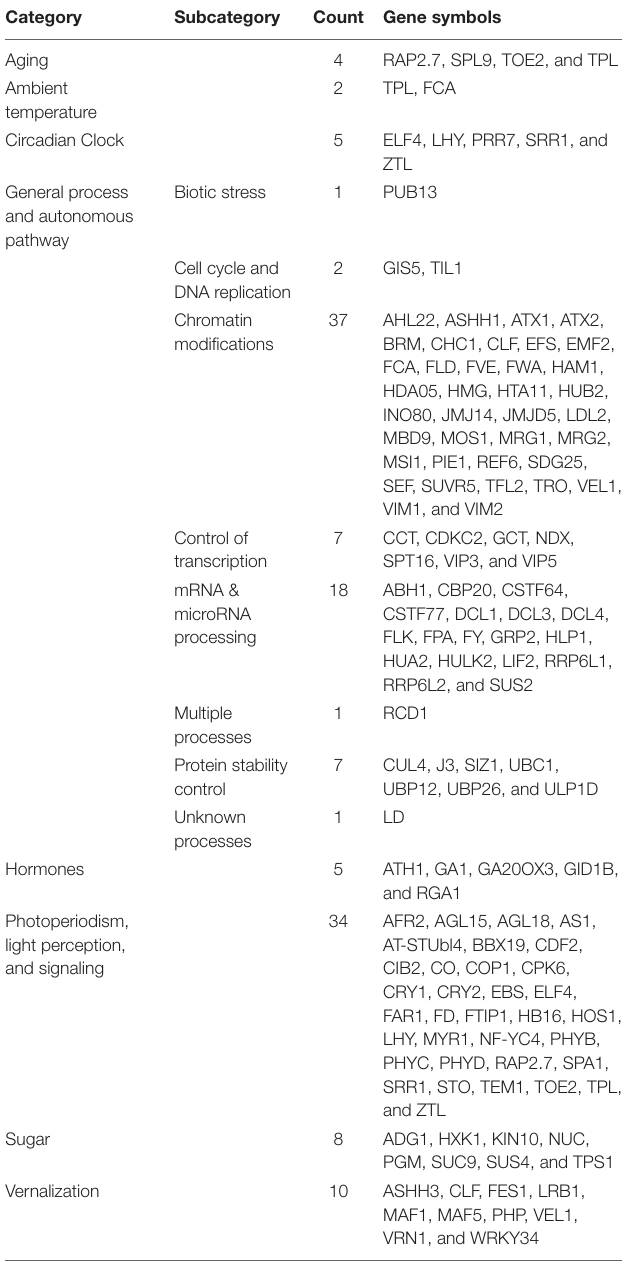
TABLE 1 | Classification of flowering genes by their functions in the FLOR-ID database.